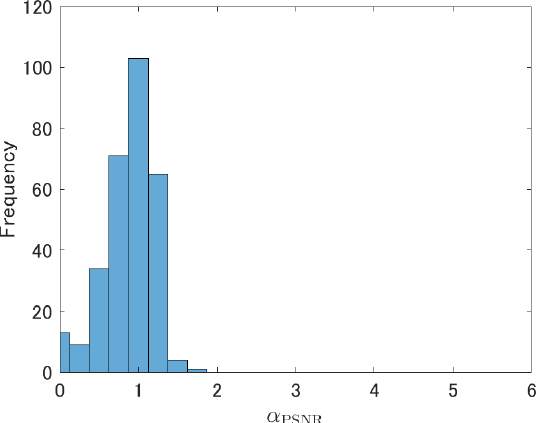
Figure 7. Histogram of the 𝛼 values that maximize the PSNR for each output